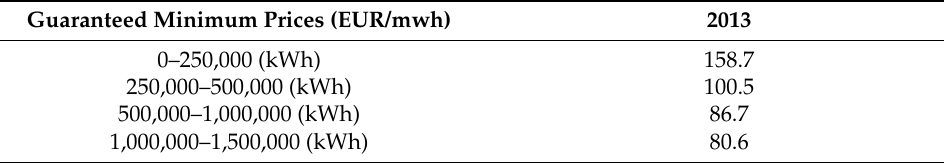
Table 2. Minimum guaranteed prices in 2013 [23].